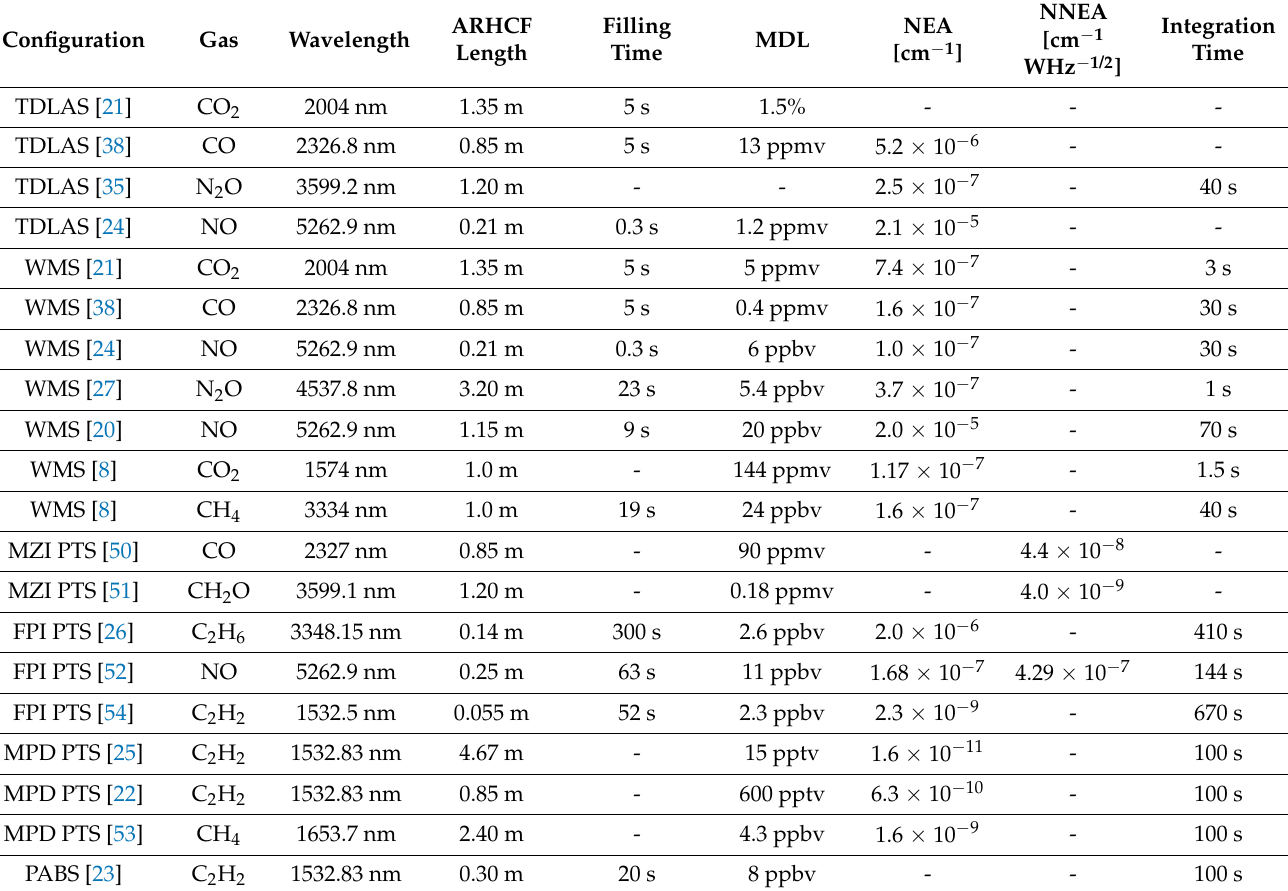
Table 2. Comparison of the performance of the ARHCF-based gas sensors.